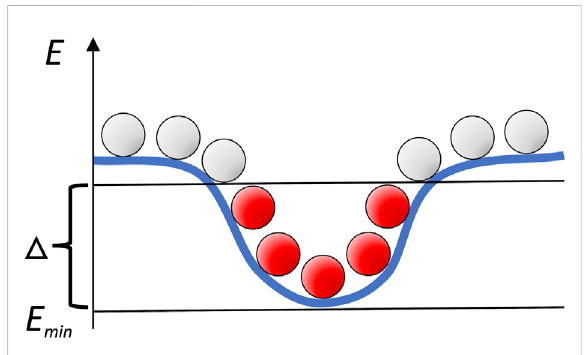
FIGURE 1 Schematic mapping of the intermolecular energy landscape by systematic sampling. Clusters of low-energy docking poses (in red) correspond to the energy